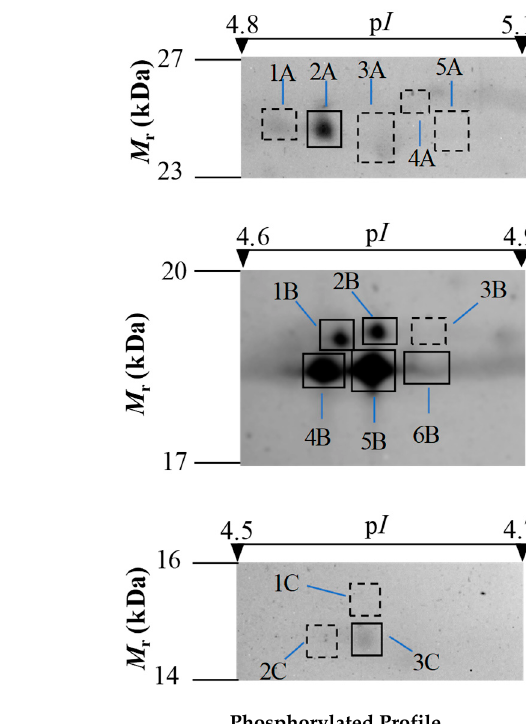
Figure 3. Representative 2-DE gel images of reference, dephosphorylated and phosphorylated profiles of three different zones ( A – C ). Reference profiles on 2-DE gels were stained with Sypro Ruby fluorescent dye. Dephosphorylated profiles on 2-DE gels were stained with Sypro Ruby from total protein extracts treated with HF-P. Phosphorylated profiles on 2-DE gels were stained with Pro-Q DPS. Spots studied are numbered. The dashed squares represent missing spots either after dephosphorylation with HF-P (dephosphorylated profile) or non-phosphorylated spots identified with Pro-Q DPS (phosphorylated profile). Dashed circles represent newly arisen spots after dephosphorylation as compared with reference patterns.